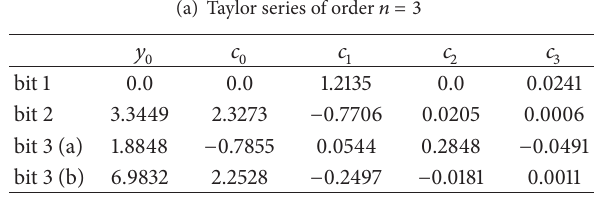
Table 1: The coefficients of LLR approximation functions for 8-PAM at SNR = 7.91 ( 𝜎 = 1.699 ).